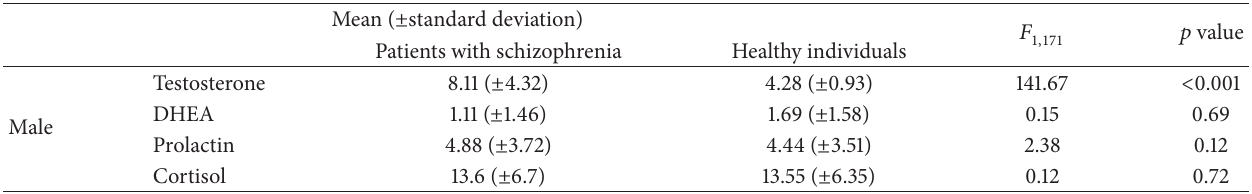
Table 3: Comparison using multivariate analysis of variance (MANOVA) of serum hormones levels in men with schizophrenia disorder and healthy men.